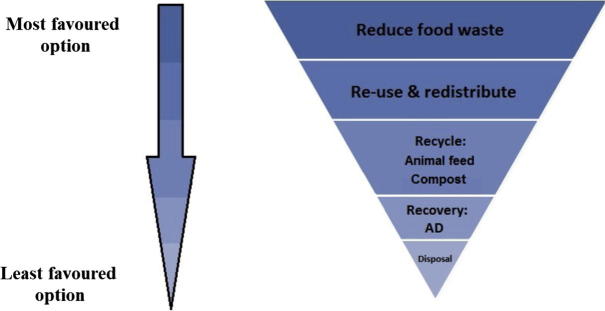
EU food waste hierarchy showing the different levels of waste disposal established under the EU Waste Framework Directive (EC, 2008). Recycling food waste as animal feed is preferable to composting, anaerobic digestion (AD), or disposal in landfill, the latter of which is to be phased out by 2025 under new legislative proposals (EC, 2014). The diversion of food waste for animal feed would not necessarily reduce the availability of inputs for the AD or composting industries, because the inevitable end product of the use of food waste as pig feed – pig manure – is itself highly suitable for both composting and anaerobic digestion (Bernal et al., 2009, Fairlie, 2010, Holm-Nielsen et al., 2009, Stuart, 2009). Image adapted from (Papargyropoulou et al., 2014).